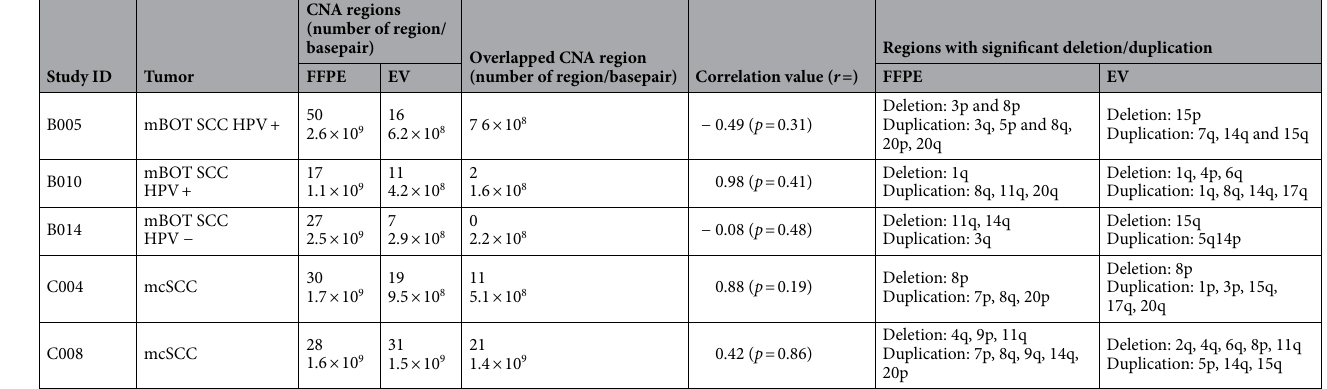
region involving squamous lineage transcription factors TP63 and SOX2 and the oncogene PIK3CA , which was also a group of mutations found in the TCGA dataset 21 . In contrast, patient #B-010 had a significant deletion observed in Chr 1q while regions with duplication were observed in Chr 8q, 11q and 20q. These findings are not observed in prior published datasets 21,22 . In the non HPV-driven metastatic base of tongue patient (#B-014), the only finding that is consistent with prior published dataset is in the duplication observed in Chr 3q. In the metastatic cutaneous squamous cell cancer samples, consistent with published literature were regions of duplica- tion found in Chr 7p, 8q, and 20q seen in both FFPE and EV samples 23 .